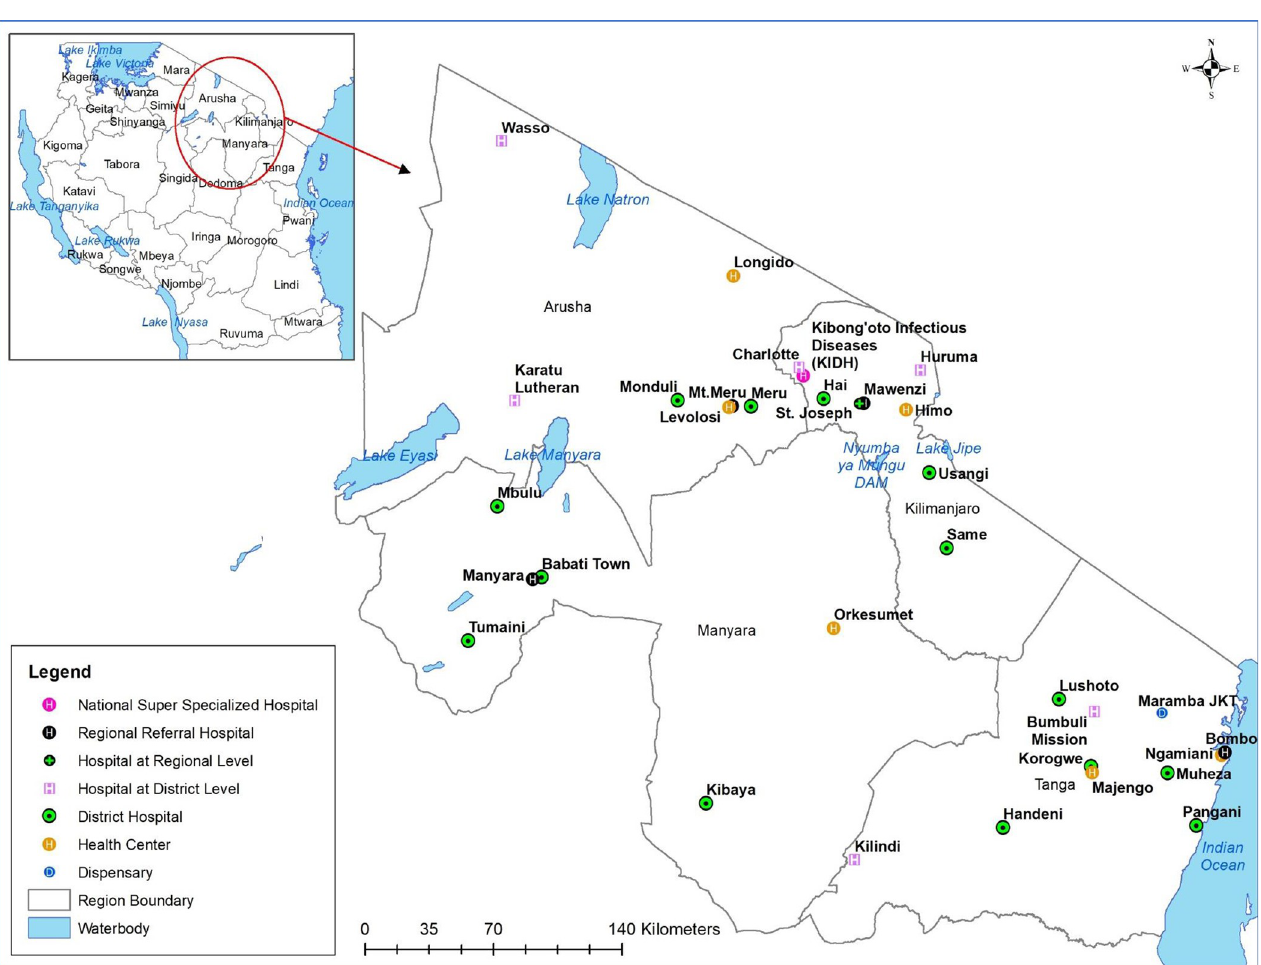
Fig 1. Study site. The map was generated by authors using administrative boundaries shapefile obtained from the Tanzania National Bureau of